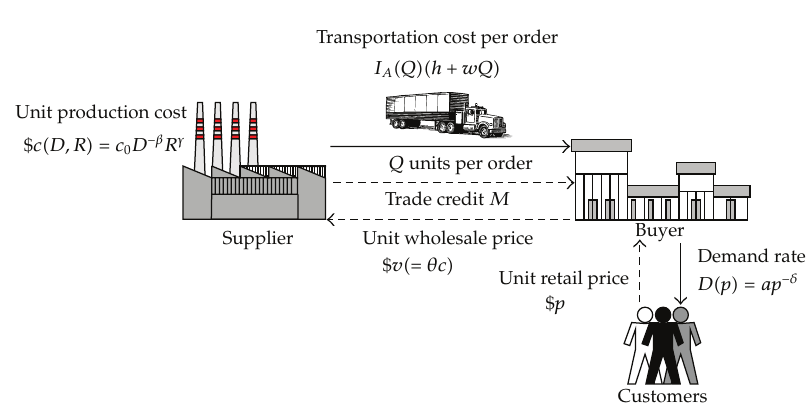
Figure 1: The supply chain